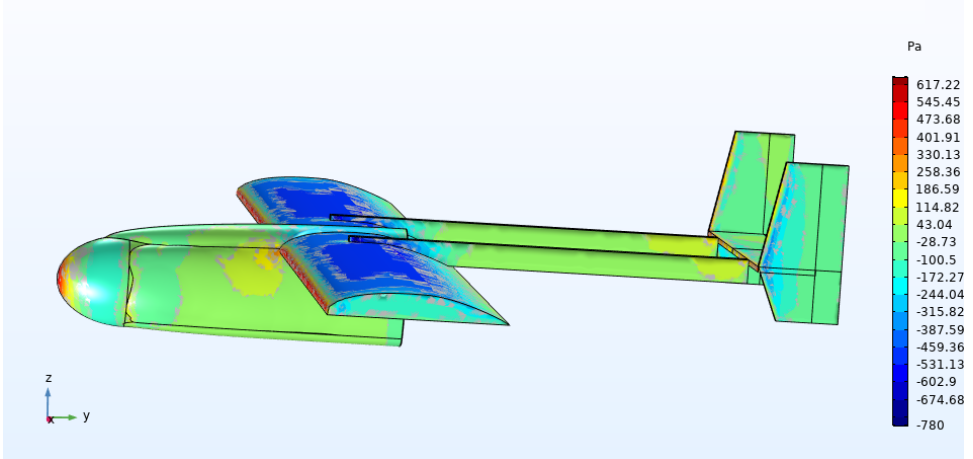
Figure 7. Lateral and top UAV focused view of maximum pressure in Pa at 2000m of altitude and 3°